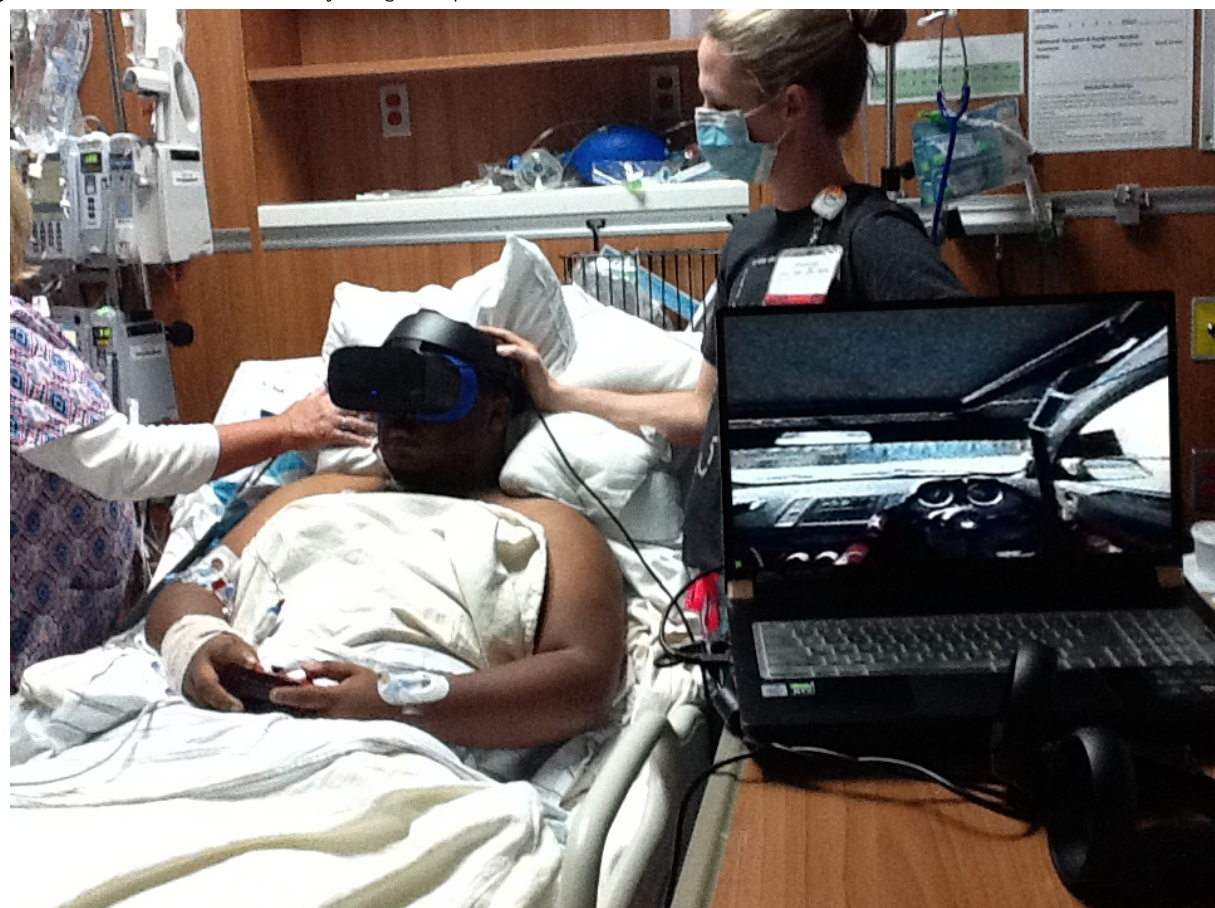
Figure 3. Demonstration of virtual reality racing in the pediatric intensive care